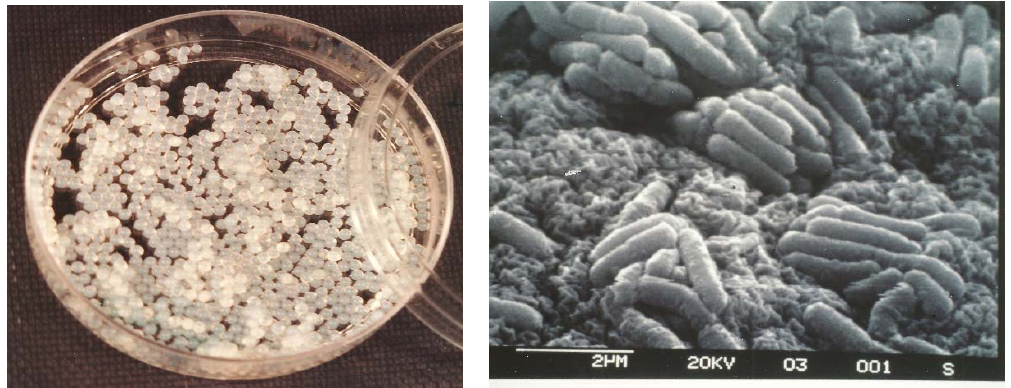
Figure 1. Observation of entrapped alginate bacteria. ( Left ) Visual appearance of alginate beads containing Listeria ivanovii WSLC 3009 (10 8 Colony Forming Unit (CFU) mL − 1 ) in a Petri dish. ( Right ) Scanning electron micrograph of L. ivanovii WSLC 3009 immobilised in alginate beads (×10,000).